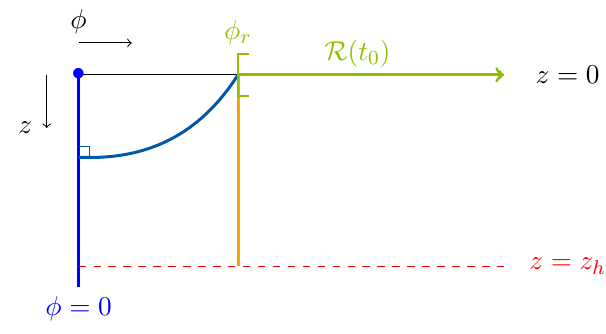
Figure 7 . The candidate RT surfaces of an infinite-length radiation region confined to a single exterior region of the two-sided planar BTZ at t = t . The orange line entering the horizon is the 0 Hartman-Maldacena surface, whereas the blue arc which ends perpendicularly on the brane is the island-producing exterior